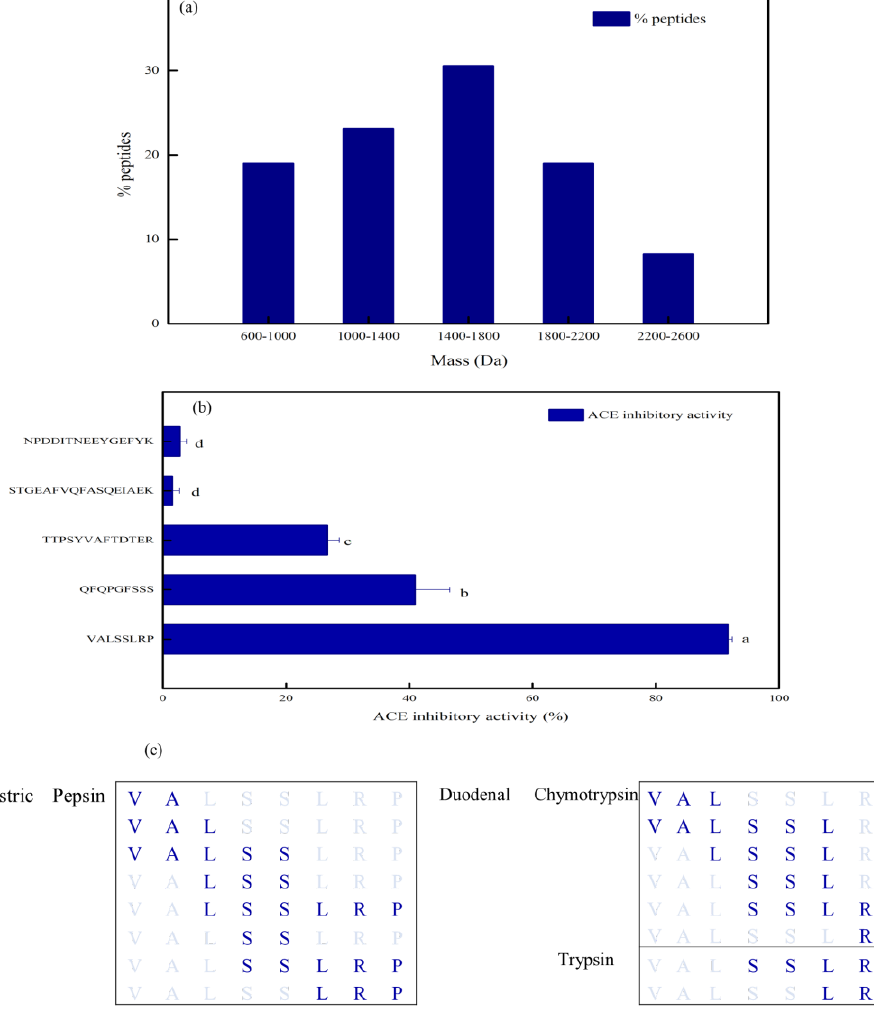
Figure 3. ( a ) Molecular mass distribution of 121 peptides. ( b ) The ACE inhibitory activity of five peptides (sample concentration: 1 mg/mL), significant marks in the figure (lowercase letters a – d), containing the same letter means no significant difference ( p > 0.05). ( c ) In silico simulated digestion of the peptide VALSSLRP.